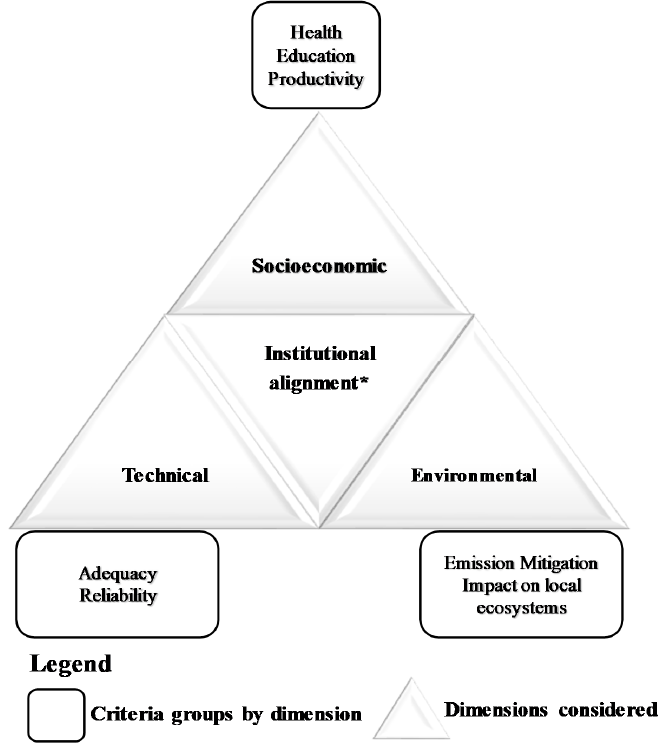
Figure 7. Sustainability assessment dimensions and criteria [31]. (*) The institutional dimension is shown through the unique criterion considered in this regard. Table 2. Sustainability dimensions and criteria of the evaluation methodology.